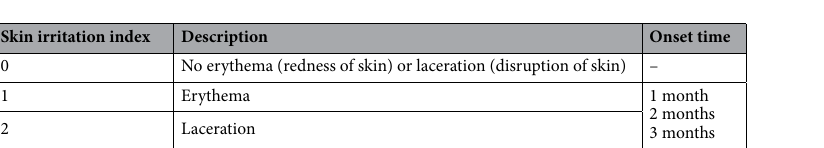
Table 1. Skin irritation index and onset time of skin